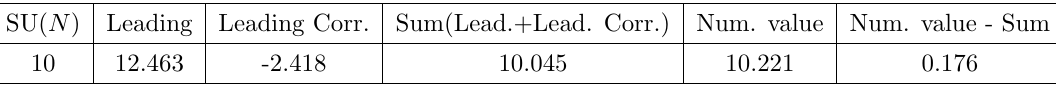
Table 16 . Comparison of N -ality 9 k -strings for